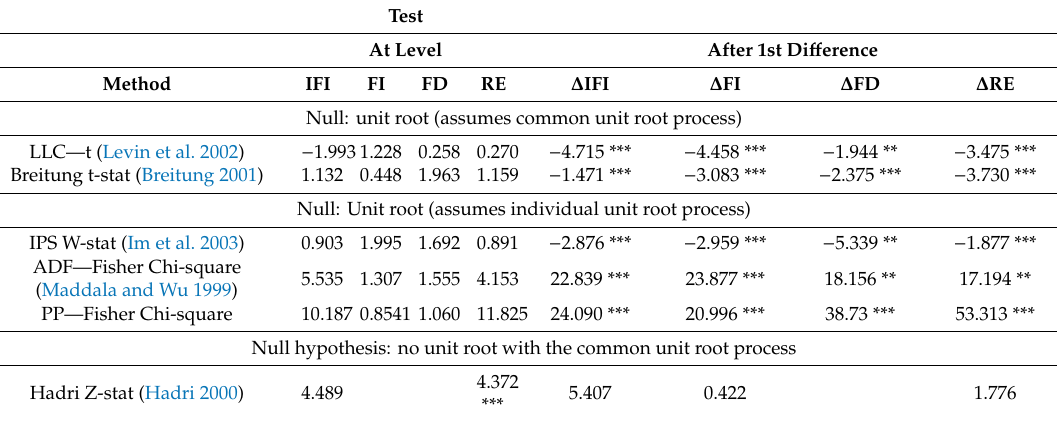
Table 2. Panel unit root test.